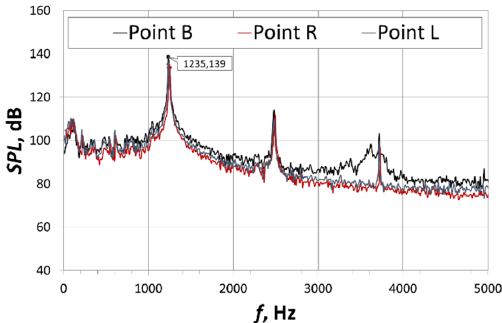
Figure 14. Spectral analysis of SPL for velocity in channel equal to 50 m/s—experimental data.